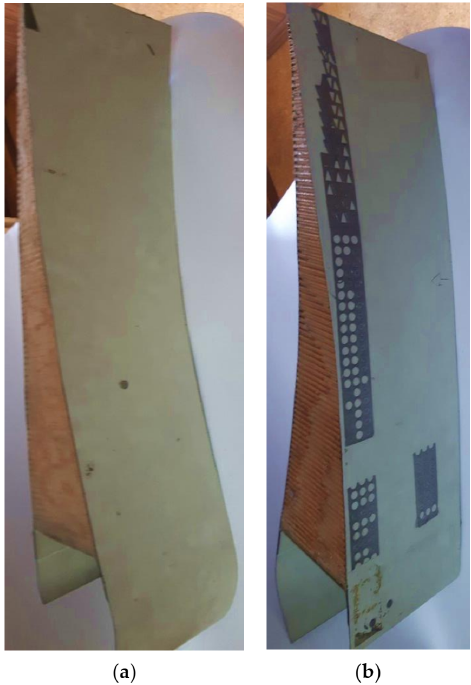
Figure 13. NDE test pieces (landing flap transversal portion, containing mainly air) of ( a ) Boeing-777 plane wings, fabricated for the maker ( b ) with internal artificial flaws located in unknown